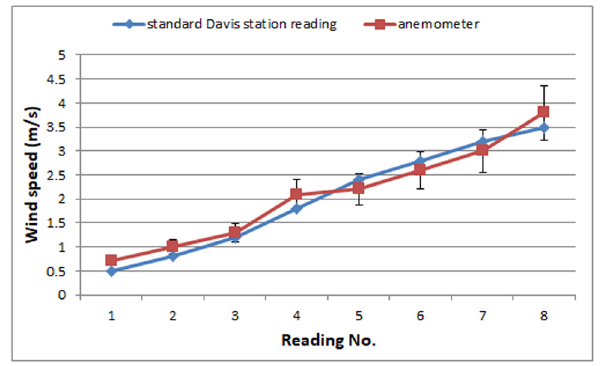
Figure 6: Calibration for